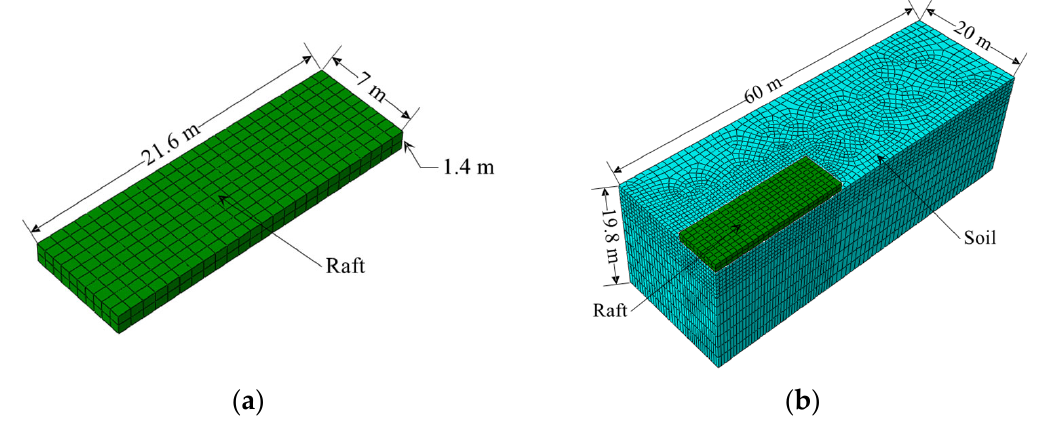
Figure 8. Finite element model: ( a ) raft; and ( b ) FEM model.